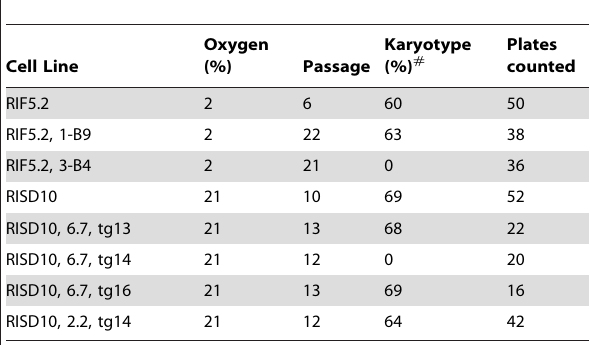
Table 1. Rat embryonic stem cell derivation efficiency. Table 2. Karyotype of targeted rat ES cell